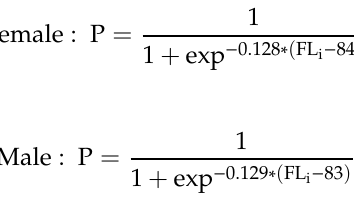
( R 2 = 0.98, n = 387). ( R 2 = 0.97, n =